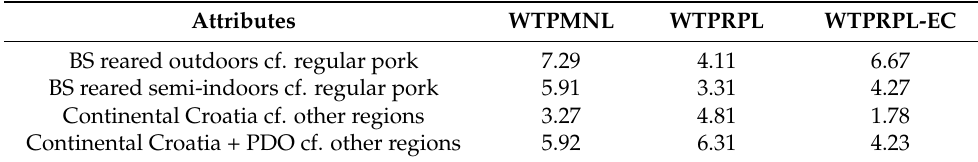
Table 5. Willingness to pay ( € /kg) for alternative specific constant and geographical information attribute compared with reference